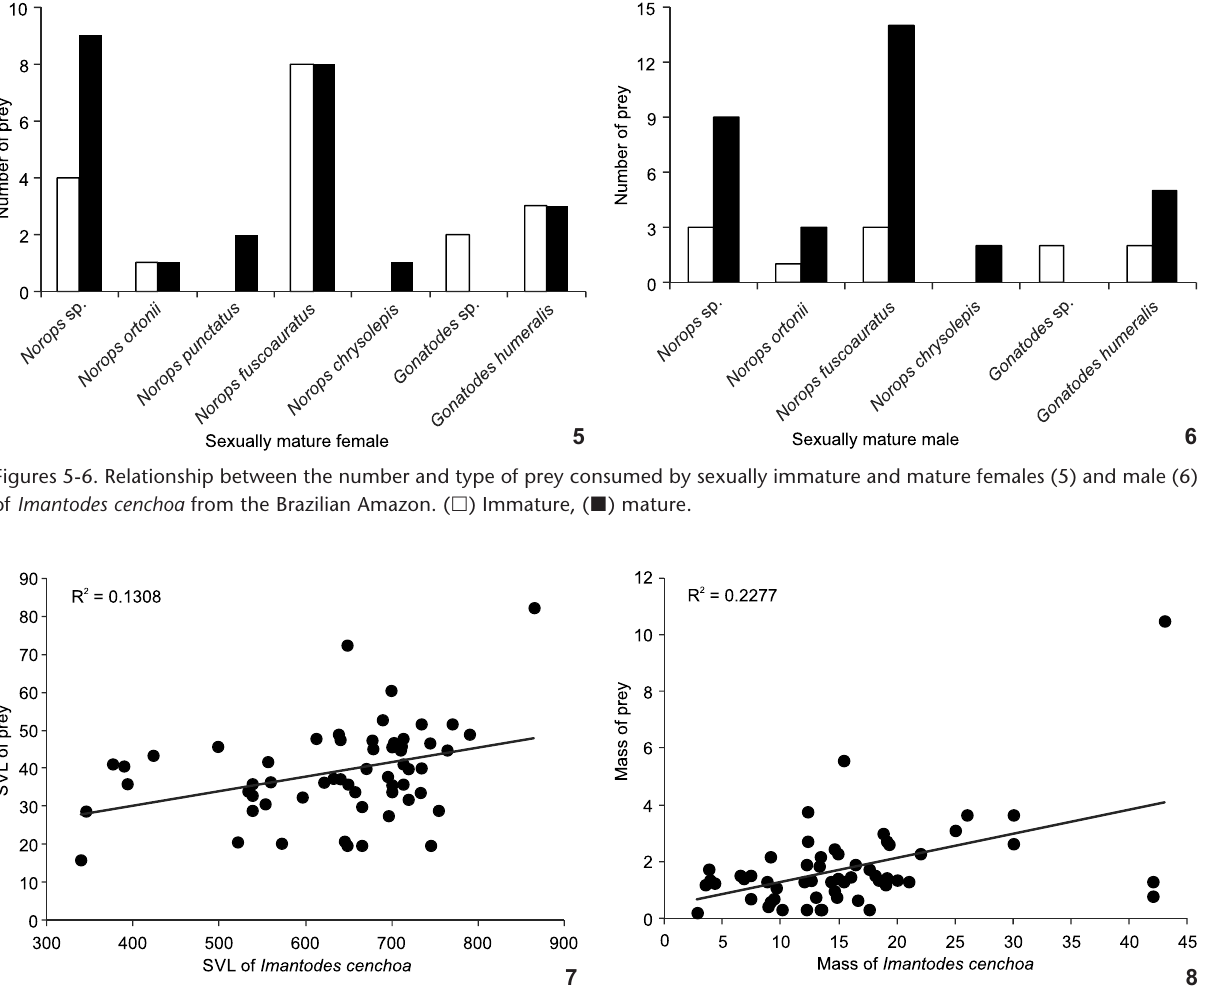
Figures 7-8. (7) Relationship between snout-vent length (SVL, in mm) of Imantodes cenchoa , and snout-vent length (SVL, in mm) of their prey, from the Brazilian Amazon. (8) Relationship between the mass (g) of Imantodes cenchoa and mass (g) of their prey, from the Brazilian